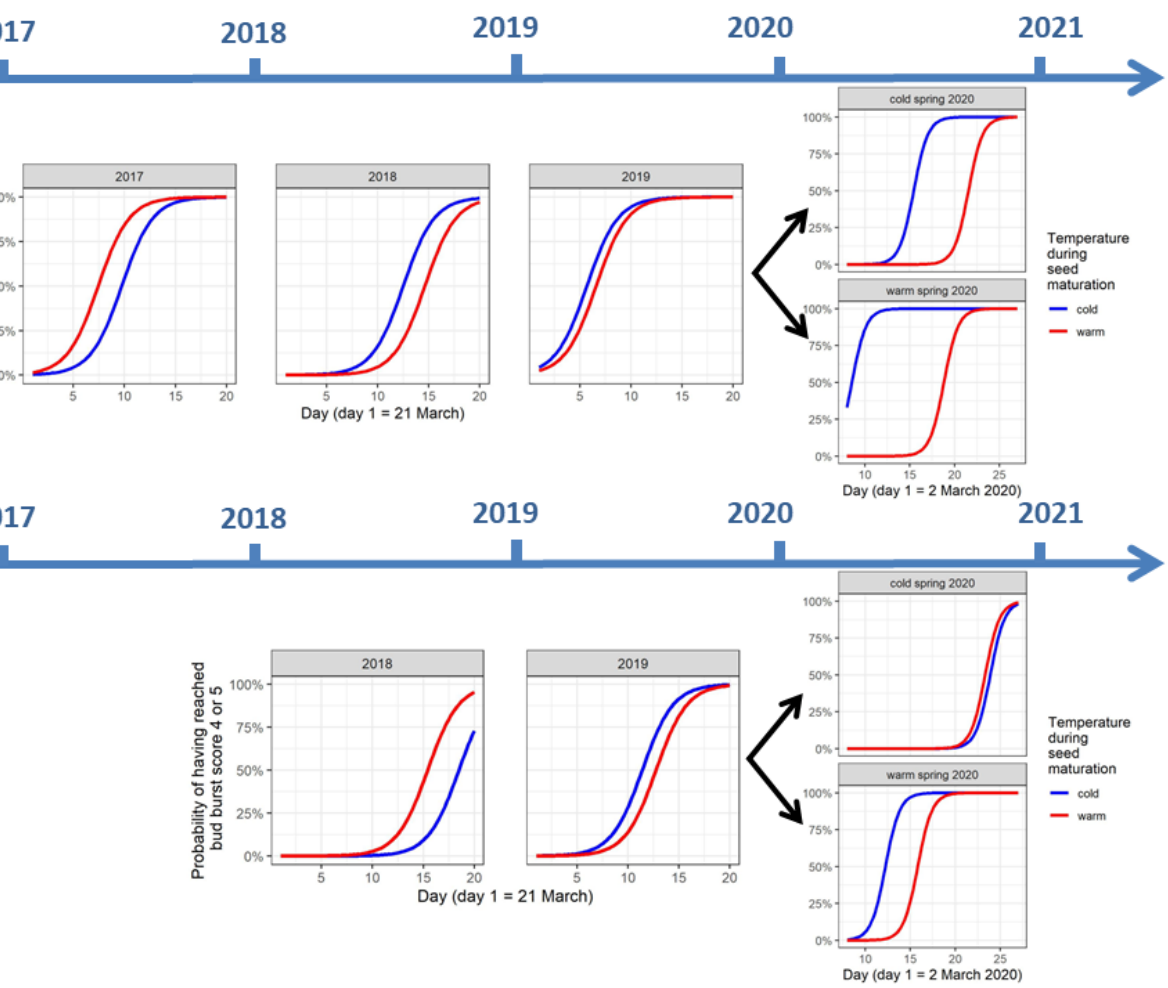
Figure 2. Modeled timing of bud burst of the seedlings from the crosses X1 and X2 for the first three (X1: 2017, 2018, and 2019) or first two (X2: 2018 and 2019) years after germination and during the spring temperature treatment in 2020, depending on the temperature during seed maturation.